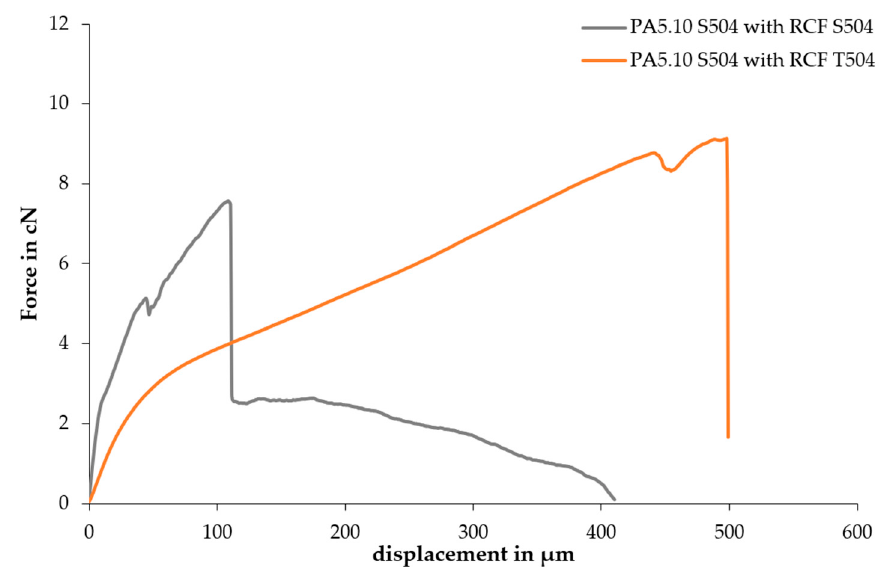
Figure 11. Force–displacement curves of the SFPT with PA5.10 S504 combined with the RCFs in a standard climate and after the temperature aging.